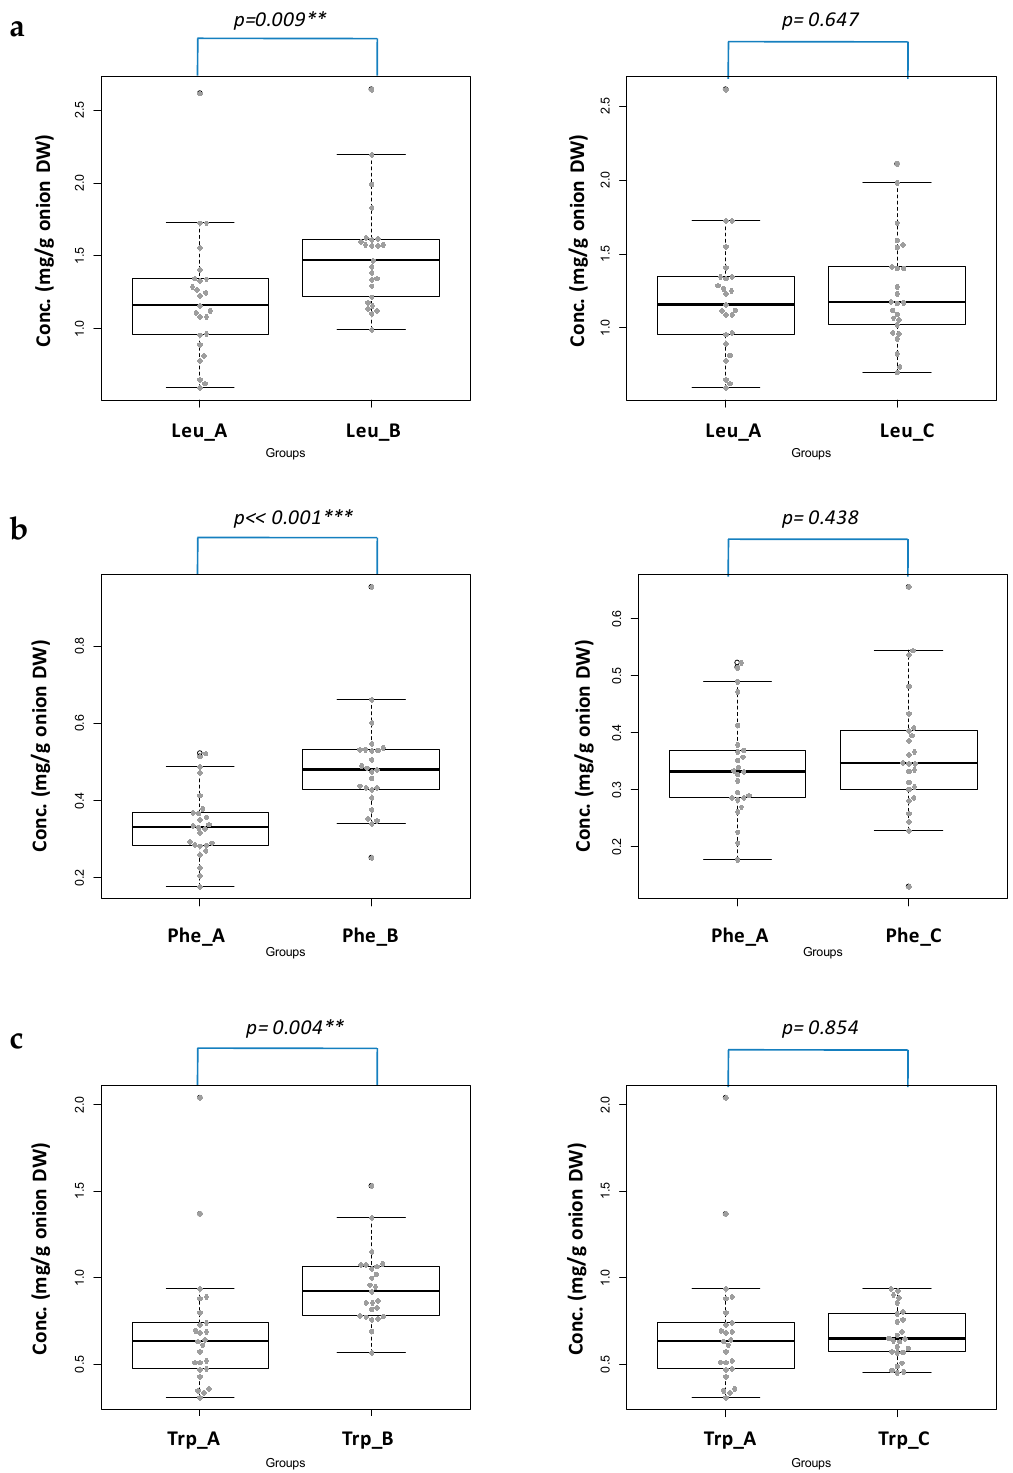
Figure 3. The Beeswarm/box plots with ANOVA/Tukey HSD analyses of the Leu ( a ); Phe ( b ); and Trp ( c ) content on the three sampled groups (left panels A versus B; right panels A versus C). The difference of the amino acid content between groups A and B is statistically